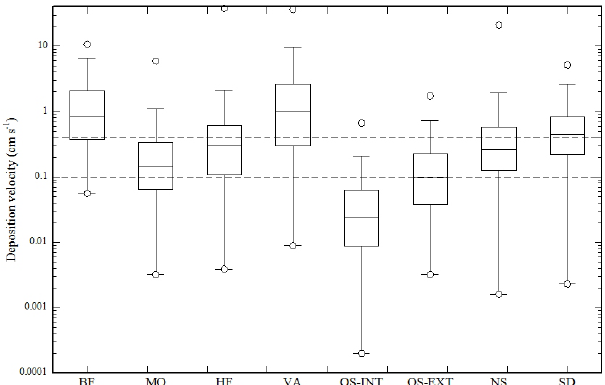
Figure 4. Box plots of night-time methanol deposition velocities at the eight study sites. Horizontal dashed lines indicate the range of deposition velocities (0.1–0.4cms − 1 ) used in global budgets (see also Table 2). Box plots show minima/maxima (circles), 5 and 95% quartiles (whiskers), the interquartile range (box) and the median (horizontal